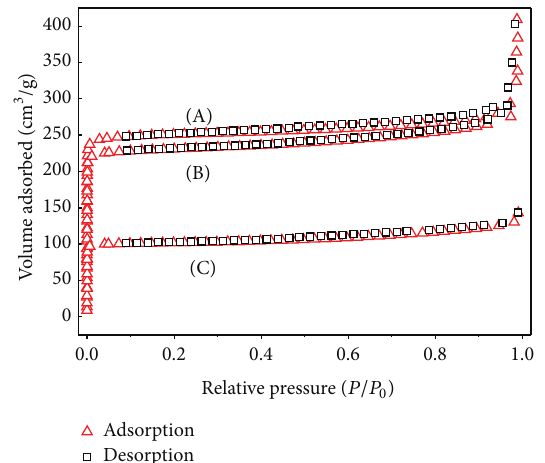
Figure 4: N 2 adsorption-desorption isotherms of the samples obtained at different H 2 SO 4 /Al 2 O 3 . (A) NaY-0-12; (B) NaY-0.67-48; (C) NaY-1.34-312.